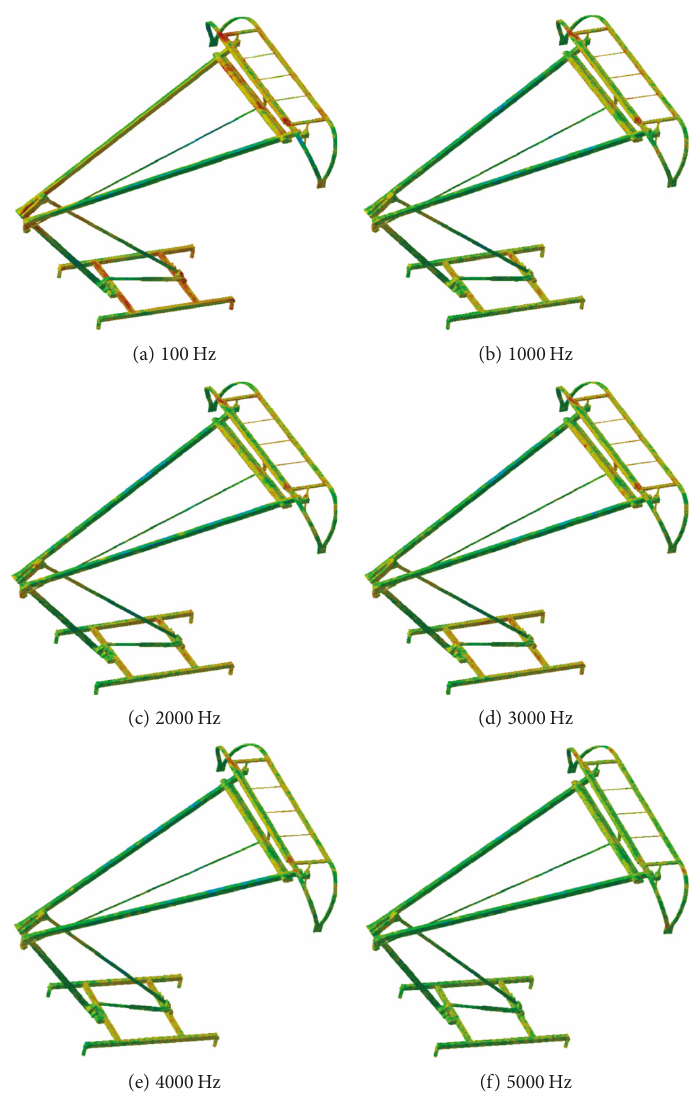
Figure 17: Radiation noise contour of improved